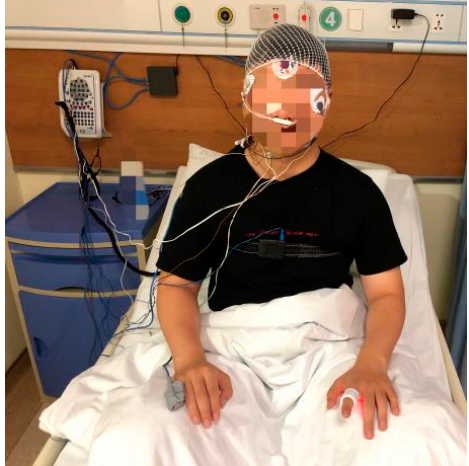
Figure 12. The subject with the smart ring being placed on the right index fi nger and the professional PSG equipment being placed on the left li tt le fi nger.